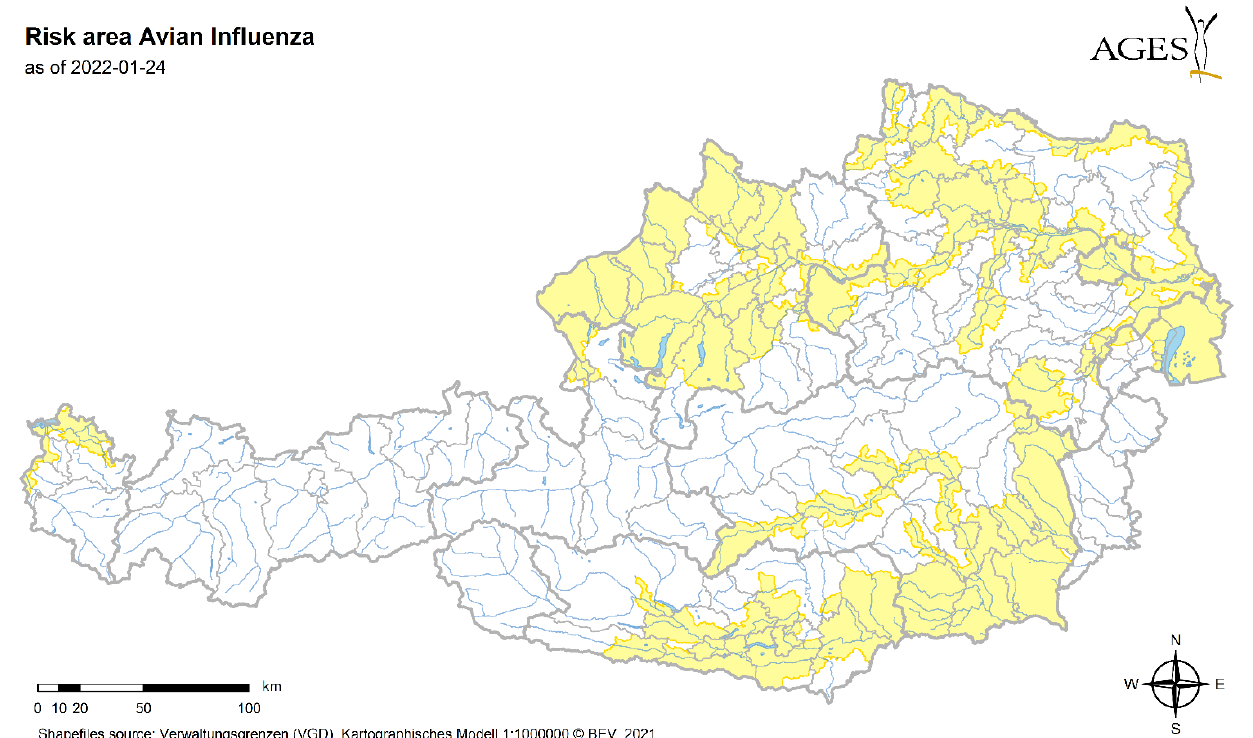
Figure 6. Risk map for Avian Influenza [34] . Areas of assumed higher risk are indicated in yellow. These areas are defined on various parameters such as water bodies, occurrence of birds and previously detected AI. (shapefile source: Verwaltungsgrenzen (VGD), Kartographisches Modell 1: 1000000 ©BEV, 2021.)